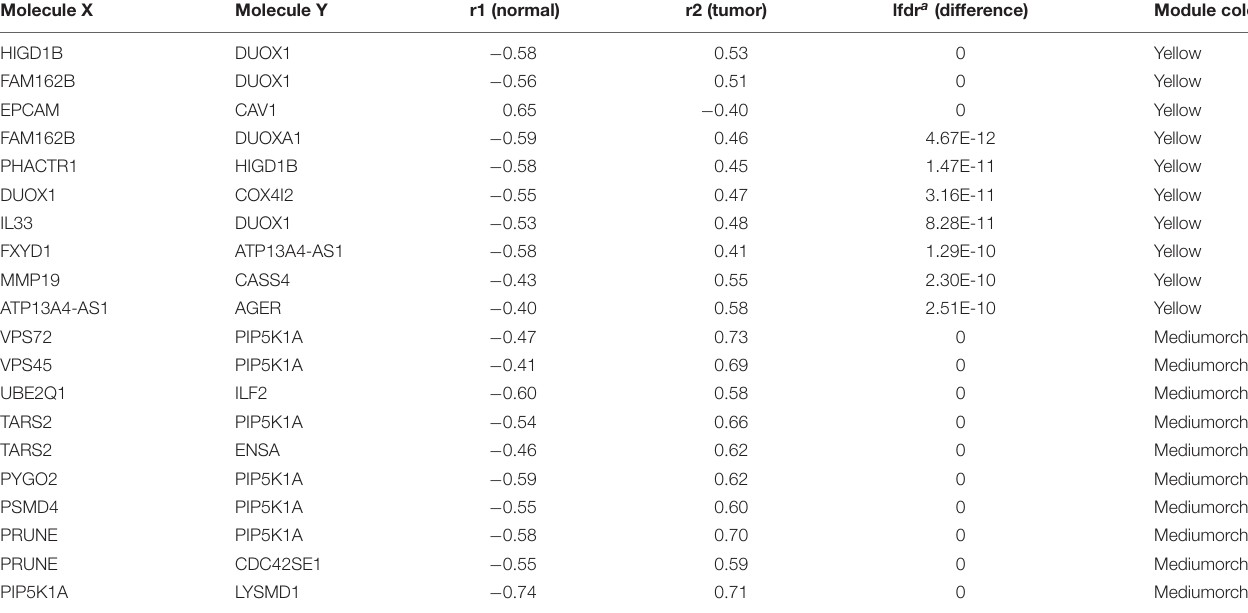
TABLE 1 | Top 10 correlated gene pairs changed to the opposite direction from the yellow and medium orchid modules between normal and LUAD samples.